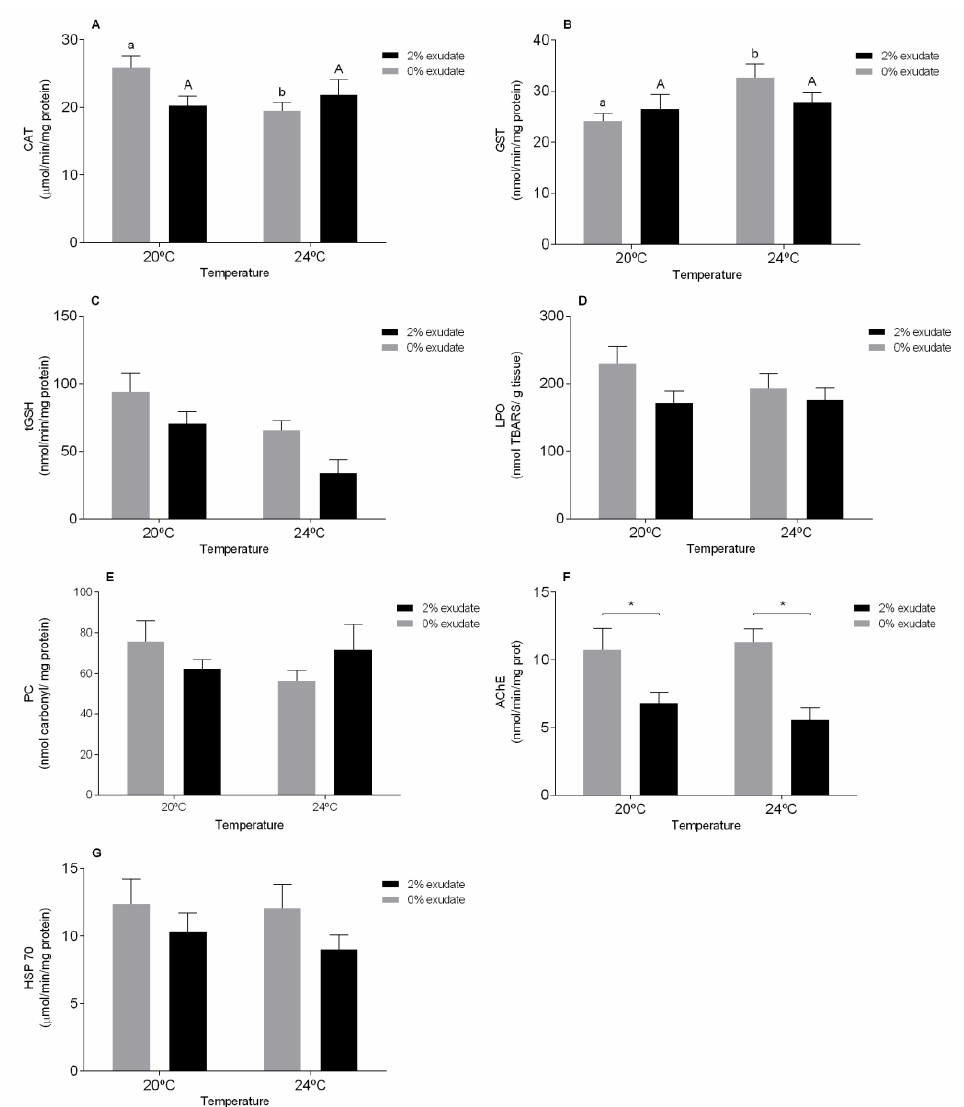
Figure 1. Biochemical biomarker responses of M. galloprovincialis gills after 96 h of exposure to A. armata exudate at different tested temperatures. ( A ) Catalase (CAT), ( B ) glutathione-S-transferase (GST), ( C ) total glutathione (tGSH), ( D ) lipid peroxidation (LPO), ( E ) protein carbonylation, ( F ) acetylcholinesterase (AChE), and ( G) heat shock proteins (HSP70). Asterisk (*) indicates a significant difference compared with the 0% and 2% of A. armata exudate from the same temperature. Different lower-case letters point at differences in the 0% exudate treatments at the different temperatures and the upper-case letters indicate differences in the 2% exudate treatments.